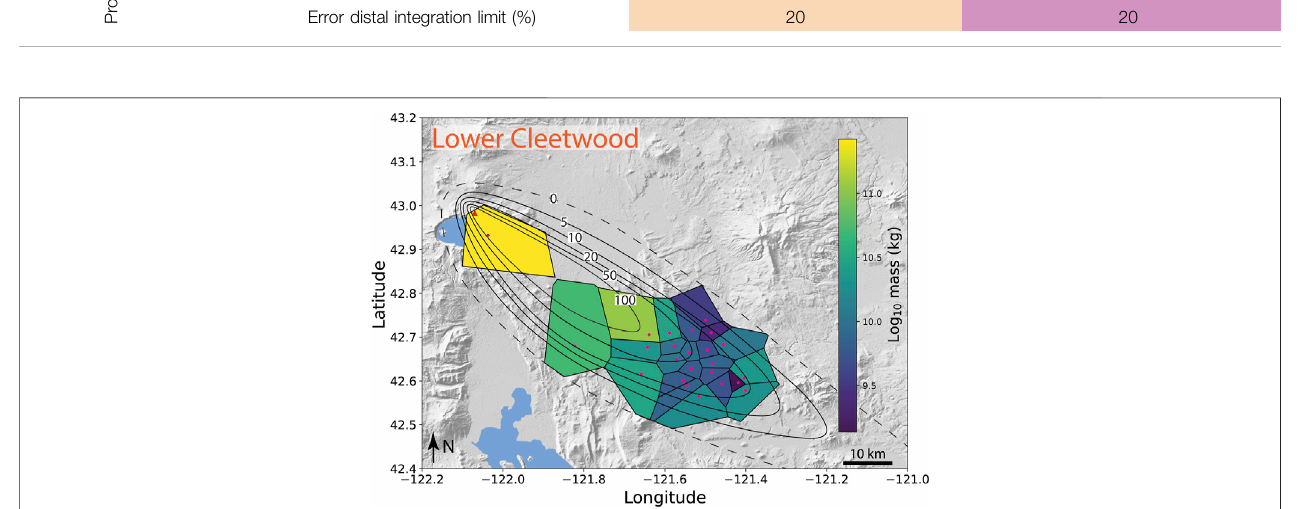
FIGURE 9 | Voronoi tessellation of lower Cleetwood of the Cleetwood eruptive sequence used to calculate the total grain-size distribution (TGSD). Pink dots indicate samples analyzed for their GSD via sieving and weighing. Isolines are in centimeters. Background is global Earth relief (Tozer et al., 2019).